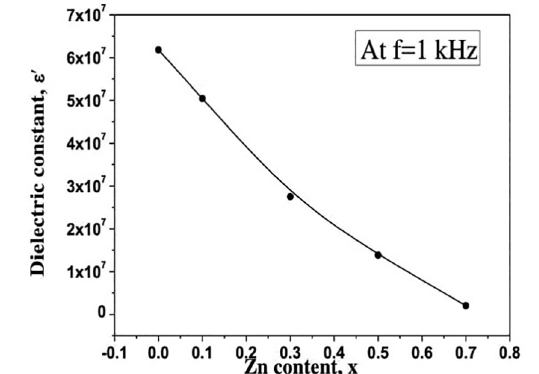
Figure 6. Variation of dielectric constant with Zn